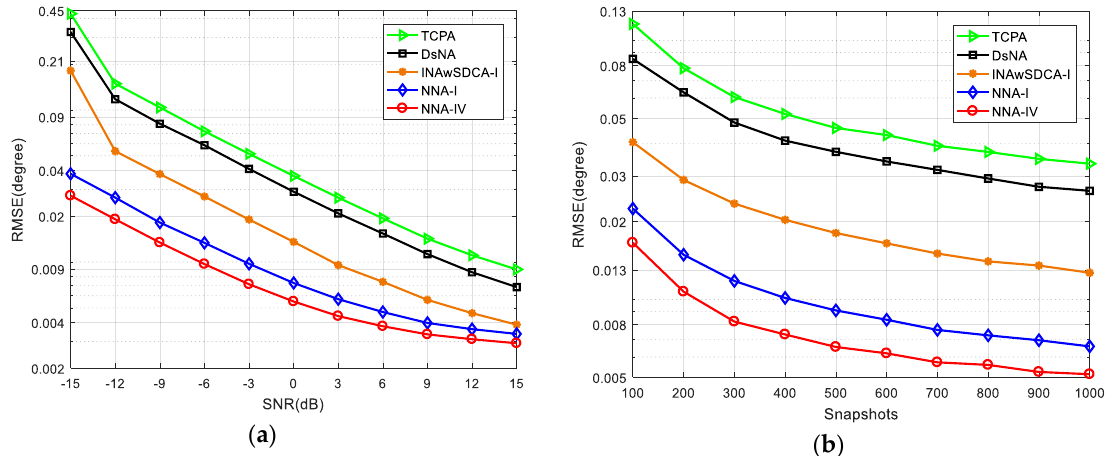
Figure 5. Comparisons of root-mean-squared error (RMSE) results by using five different sparse arrays, where the number of sensors is fixed to be 10 while that of signals is set equal to 18. ( a ) As a function of SNR, where N s = N p = 800. ( b ) As a function of snapshots, where SNR = 0 dB and N s = N p .